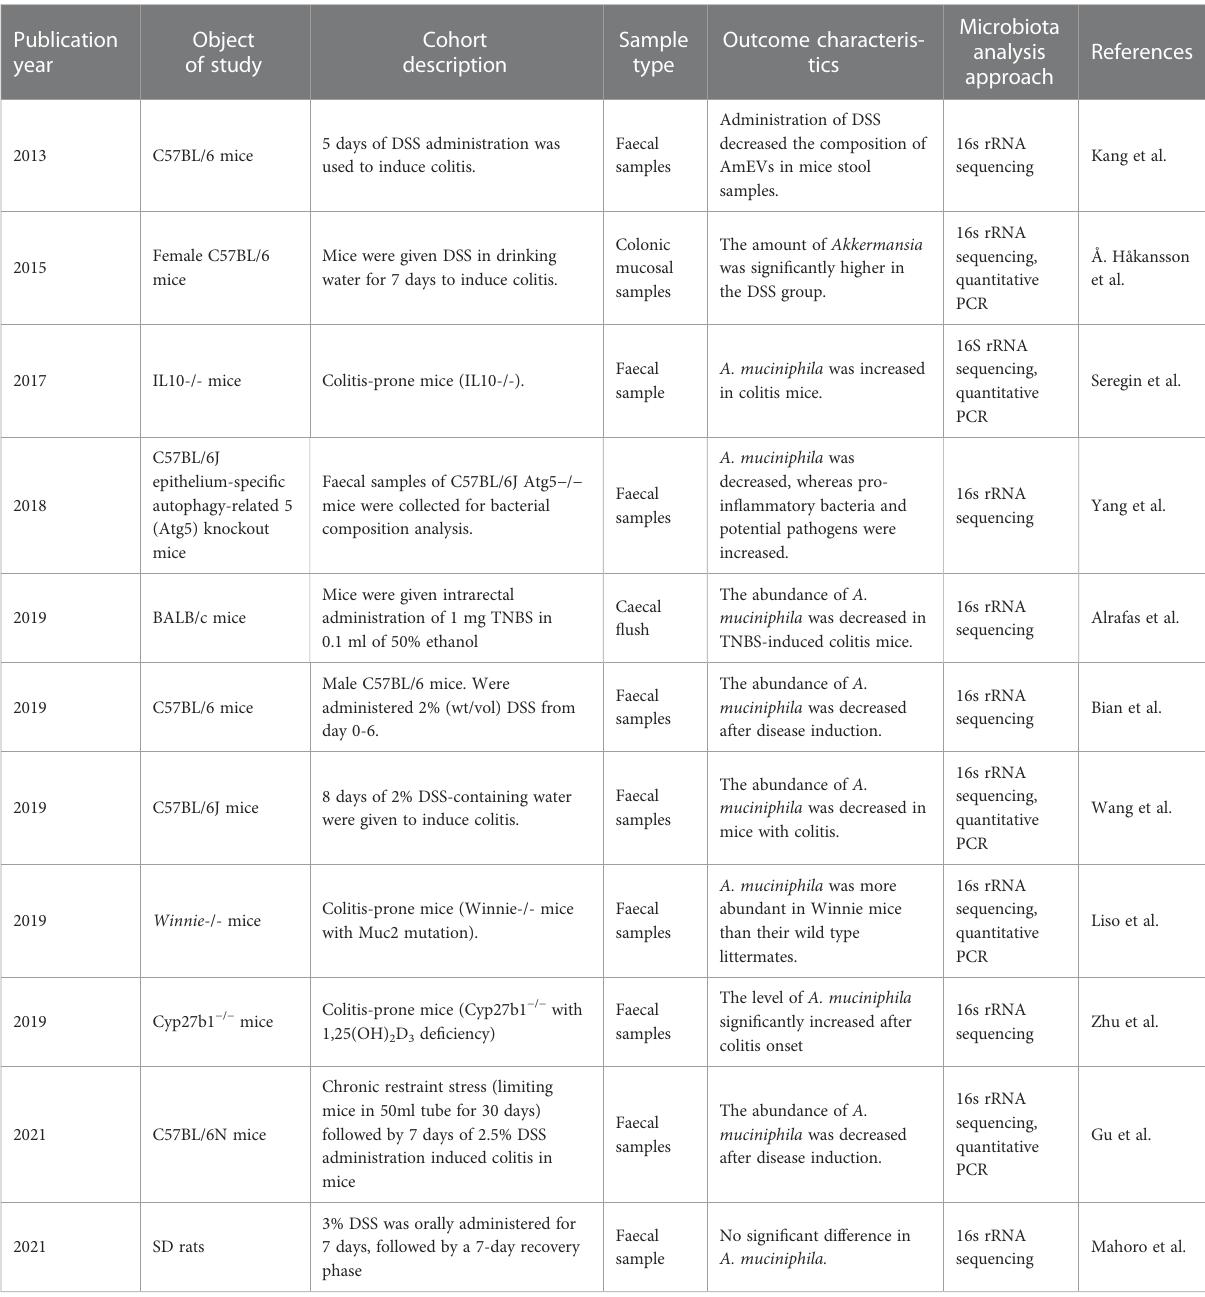
TABLE 2 Overview of animal studies of A. muciniphila related to in fl ammatory bowel